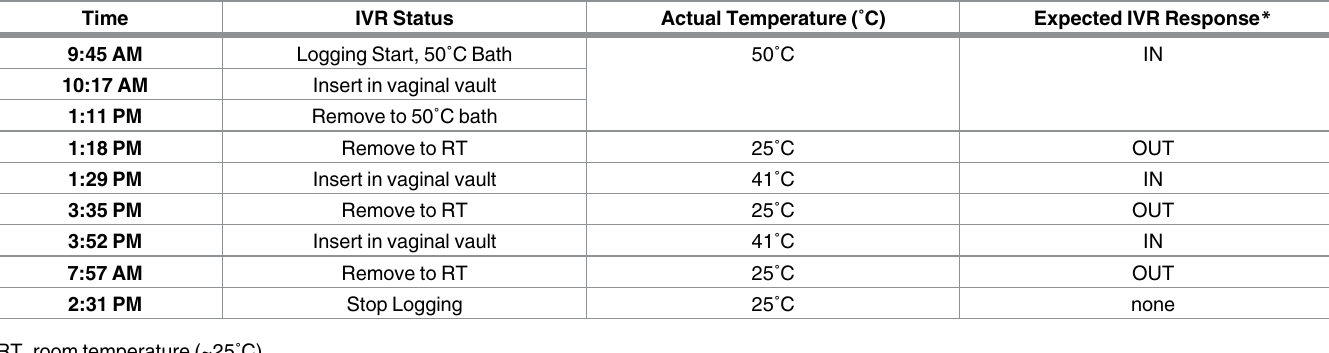
Table 1. In vivo sheep study events